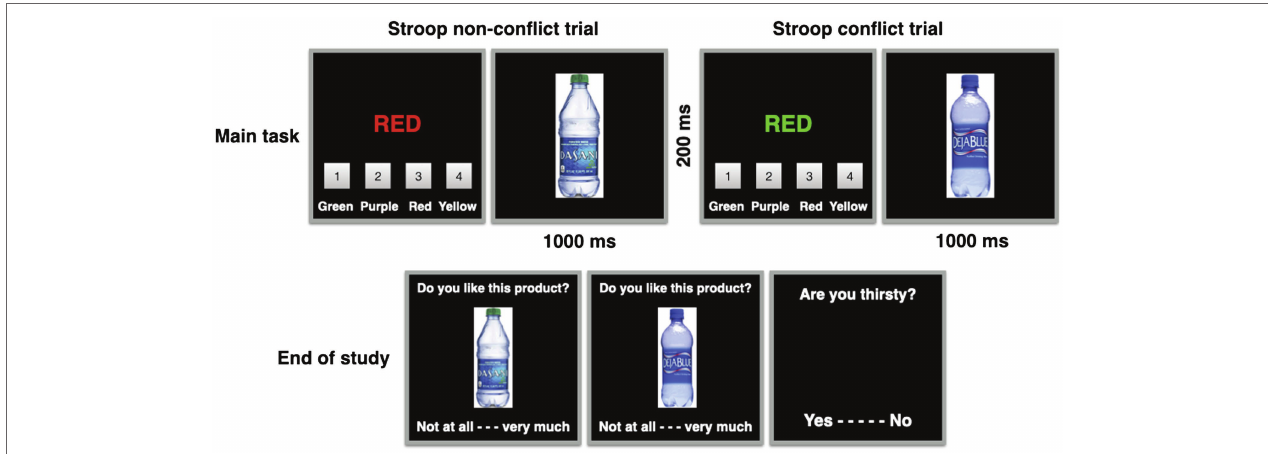
FIGURE 1 | Experimental overview. The upper half depicts a compatible non-conflict trial and an incompatible conflict trial, respectively. The lower half depicts the evaluations at the end of the study.